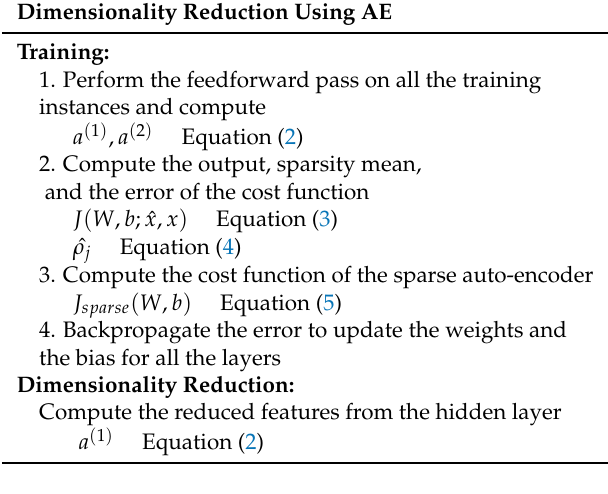
Table 4. Pseudo-code for the proposed Auto-Encoder.